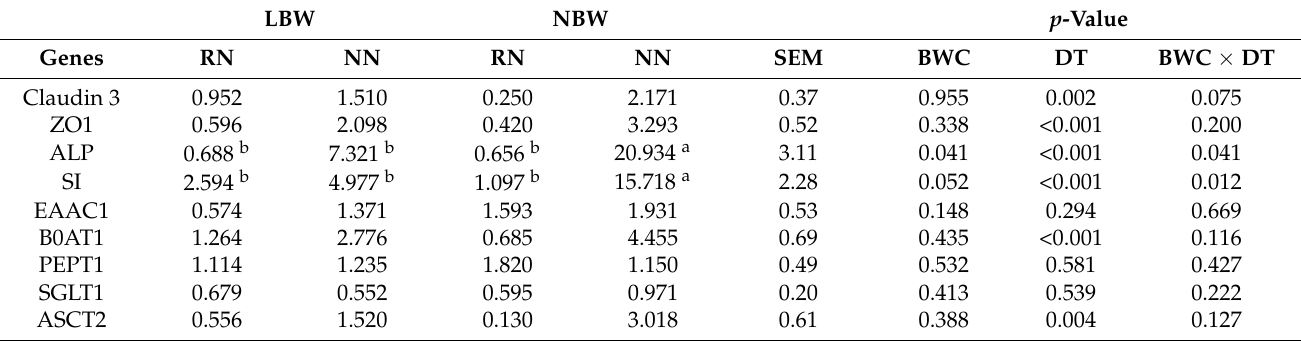
Table 3. Jejunal nutrient transporter and tight junction mRNA transcript abundance at 56 d post-weaning.